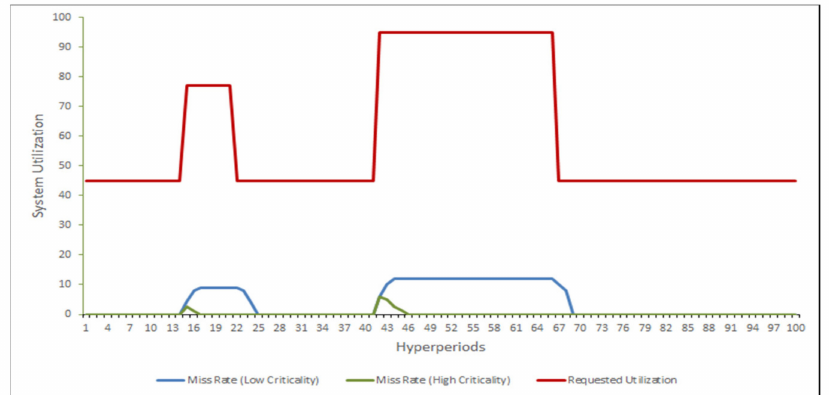
Figure 6. Feedback scheduler with transient overload.